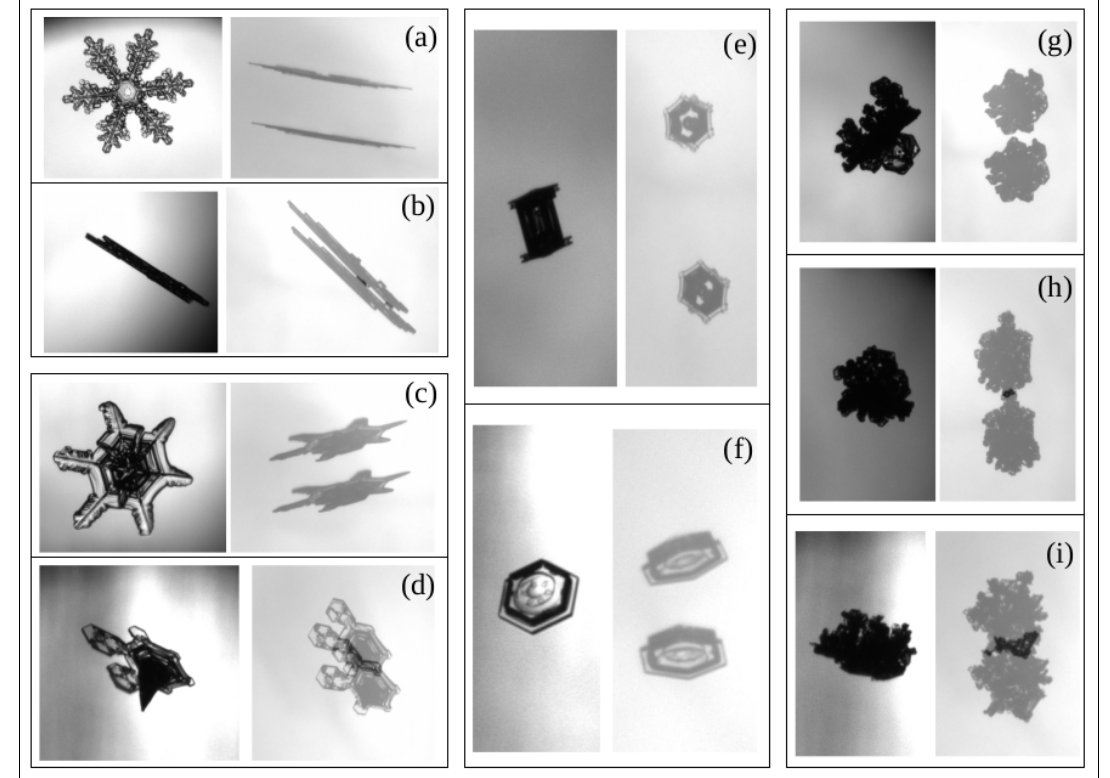
Figure 1. Shape classification is less ambiguous with dual images. Panels (a–i) show nine examples of different particles with side views ( right ) and top views ( left ). Discussion of these examples is in the